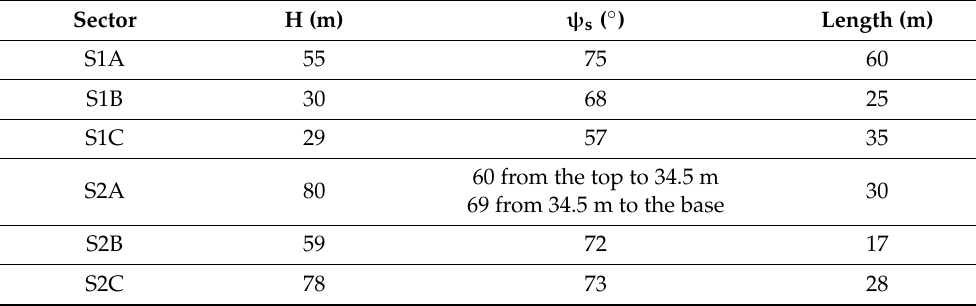
Table 5. Geometry of the slope for each sector in Slope-1.